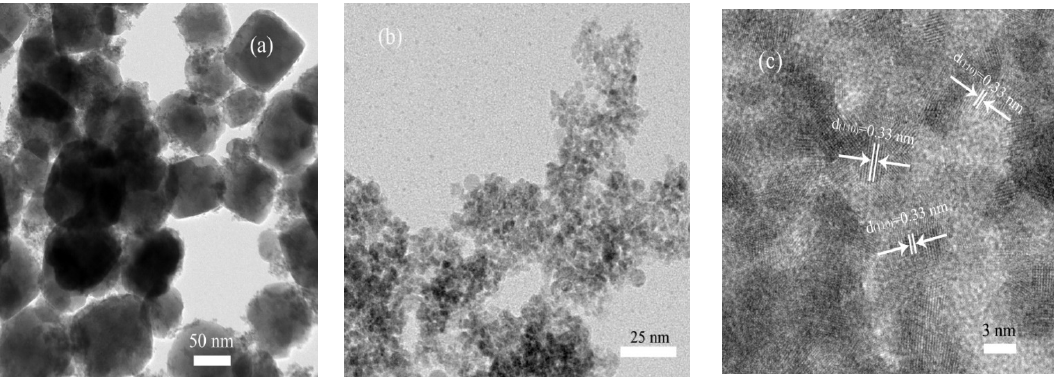
Figure 4. ( a ) TEM image of ZSO; ( b ) TEM image of SnO 2 − x -105T; ( c ) HRTEM image of SnO 2 − x -105T.